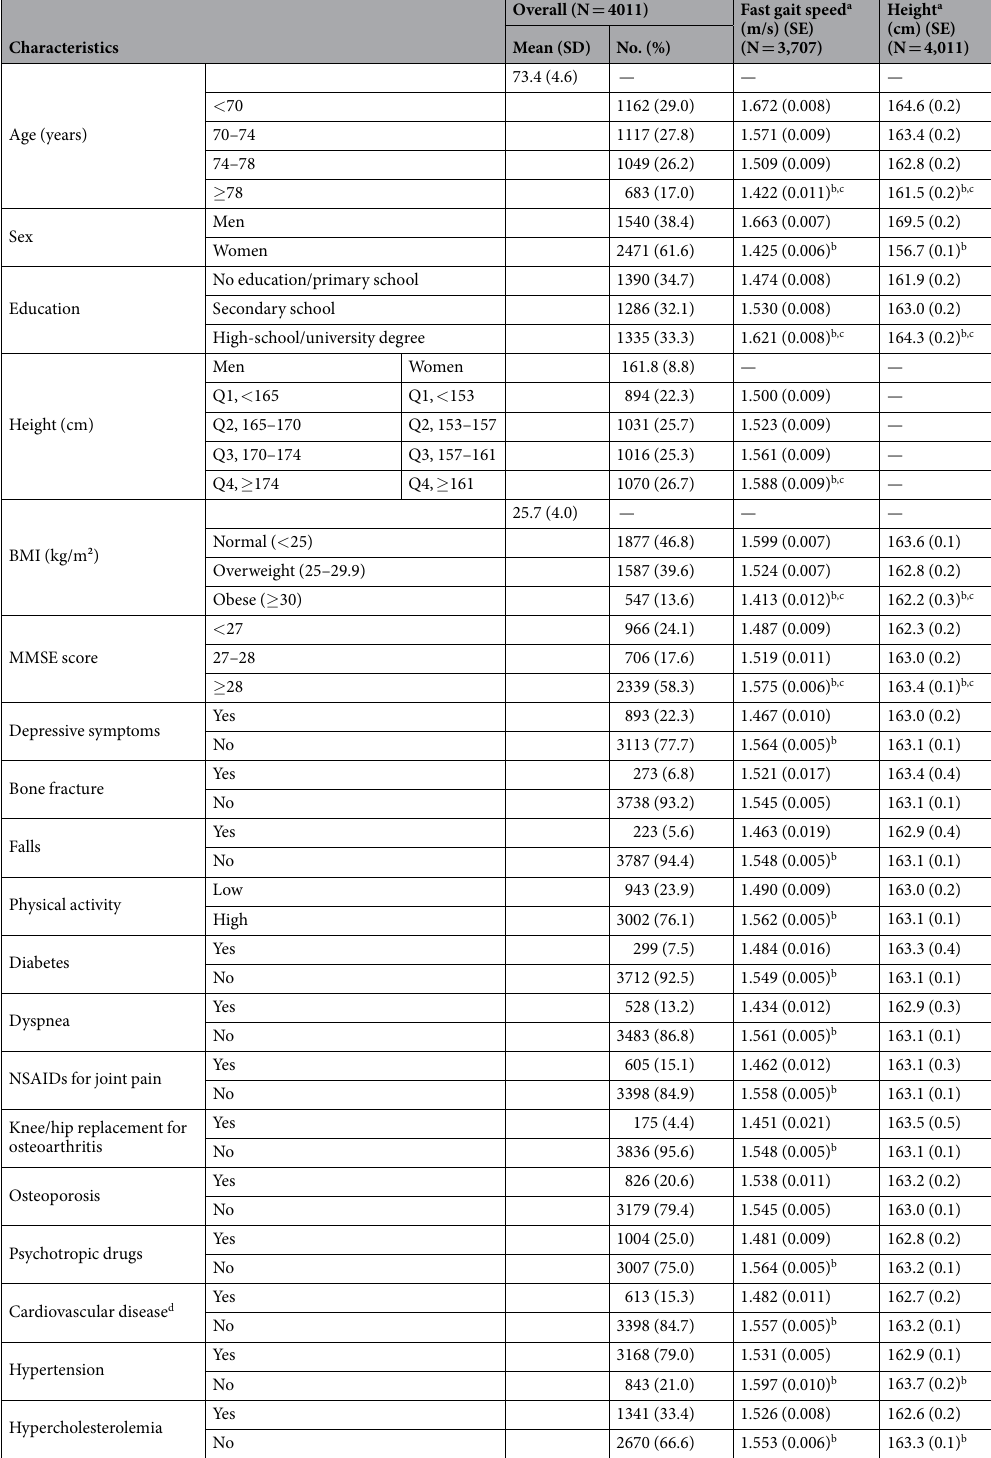
Table 1. Participants’ Characteristics at Baseline (1999–2001). Q1 (shortest)-Q4 (tallest), sex-specific quartiles of height; BMI, body mass index; MMSE, mini-mental state examination; NSAIDs, non-steroidal anti-inflammatory drugs; SD, standard deviation; SE, standard error. a Age/sex-adjusted means and standard errors (SE). Analyses based on 3707 participants with a fast gait speed measure at baseline. b Age- and sex- adjusted P-value < 0.001. c Age- and sex-adjusted P-value for trend. d Stroke, coronary heart disease, lower- limb